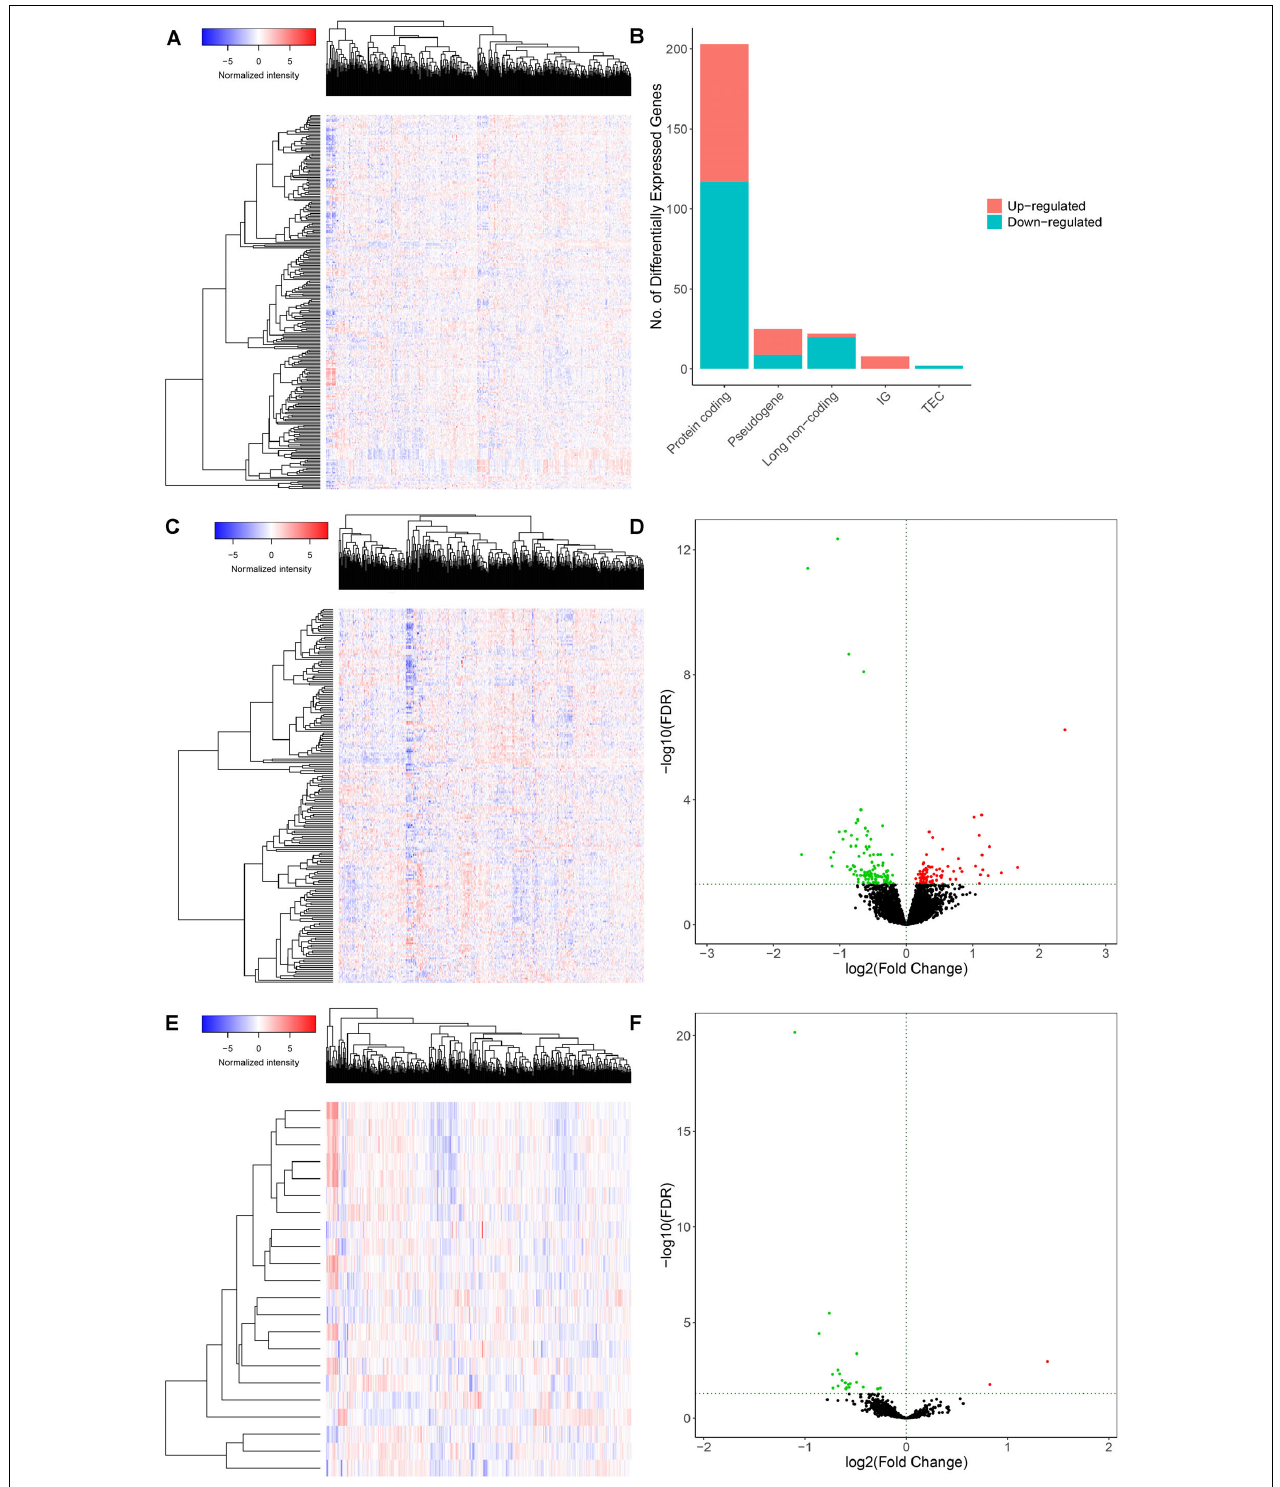
FIGURE 2 | Genes and lncRNAs which were significant differentially expressed between primary and distance metastasis colon carcinoma. The cutoffs which we set was log(fold-change) > 1.0 or < –1.0 and FDR < 0.05 and then we identified 260 differentially expressed genes (A,B) which include 203 protein-coding genes (117 downregulated and 86 upregulated) (C,D) and 22 lncRNAs (21 downregulated and 1 upregulated) (E,F) in the total of 14,447 lncRNAs, 2,588 miRNAs and 19,660 mRNAs from the TCGA database. TCGA: the cancer genome atlas.